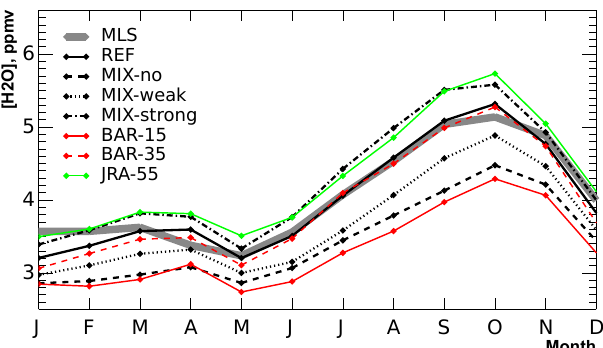
Figure 2. Annual cycle of tropical entry H 2 O at 400K (10 ◦ S– 10 ◦ N) from different sensitivity simulations with respect to vari- ations in reanalysis datasets, horizontal transport and small-scale mixing for 2011. The grey line represents MLS satellite observa- tions, for comparison. Shown are the reference simulation (REF), the cases without mixing (MIX-no), with weak (MIX-weak) and strong mixing (MIX-strong), the simulations with transport barri- ers at 15 ◦ N/S (BAR-15), at 35 ◦ N/S (BAR-35), and the simulation driven with JRA-55